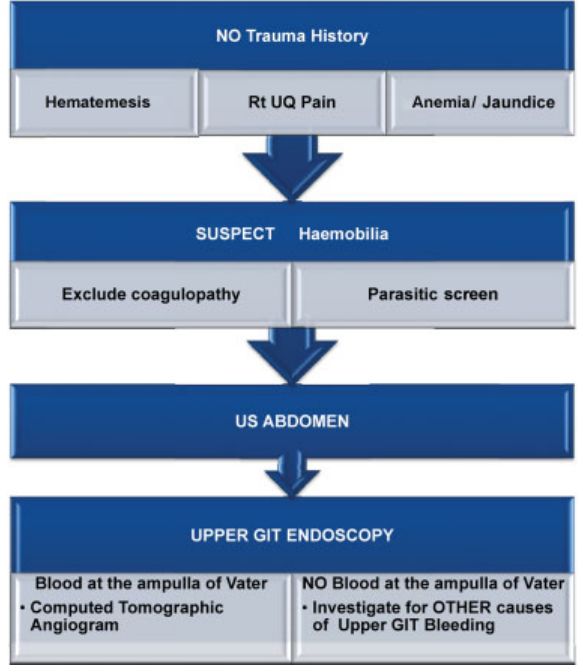
Fig. 4 Diagnostic approach for suspected non traumatic